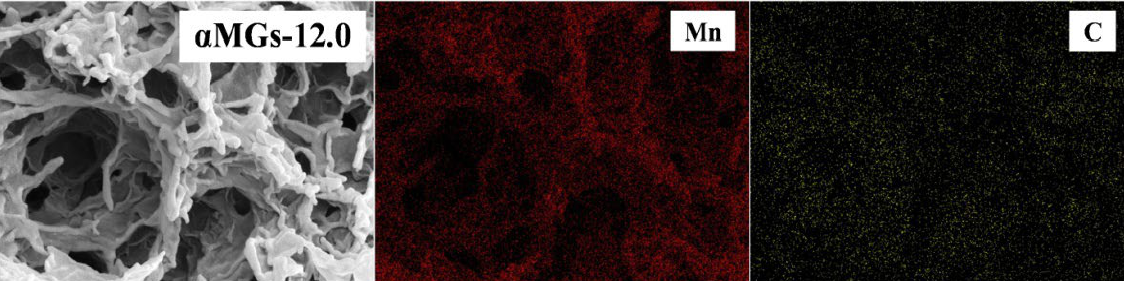
Figure 4. Elemental distributions in αMGs -12.0.